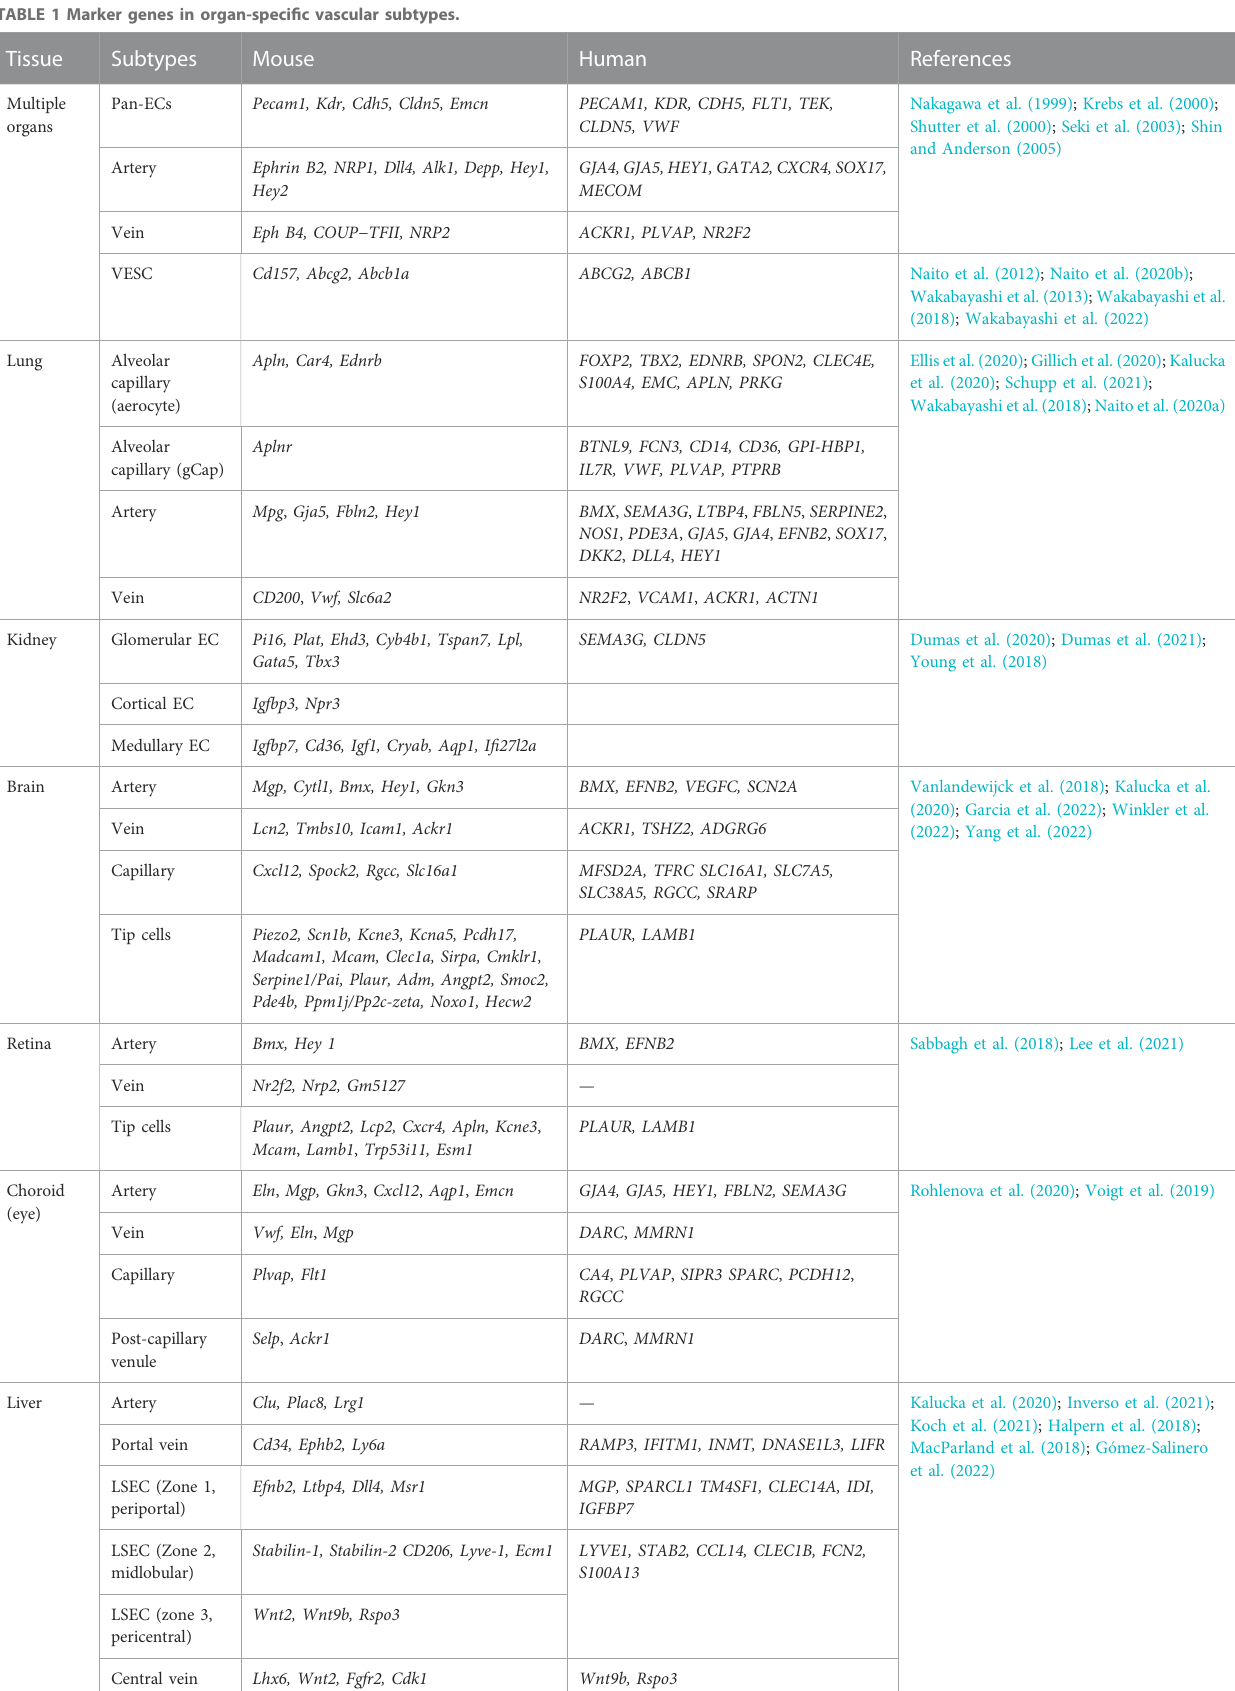
TABLE 1 Marker genes in organ-speci fi c vascular